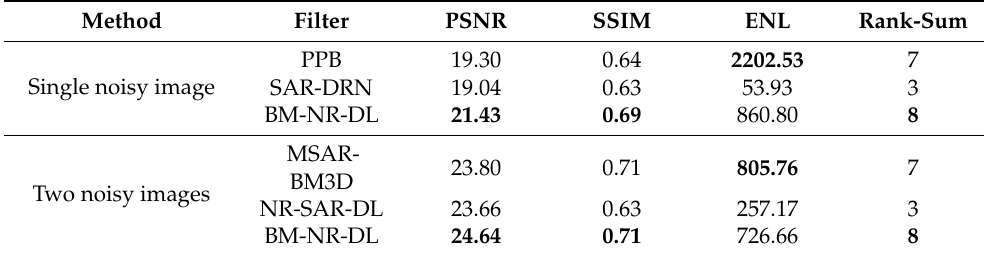
Table 2. Quantitative assessment results for the simulated